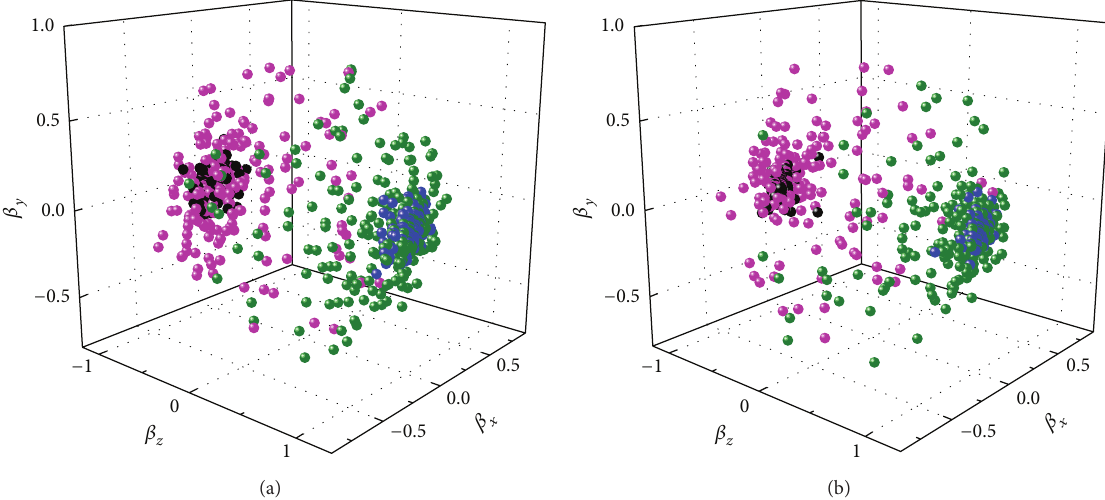
Figure 5: Same as Figure 3, but showing the scatter plots in 3D velocity